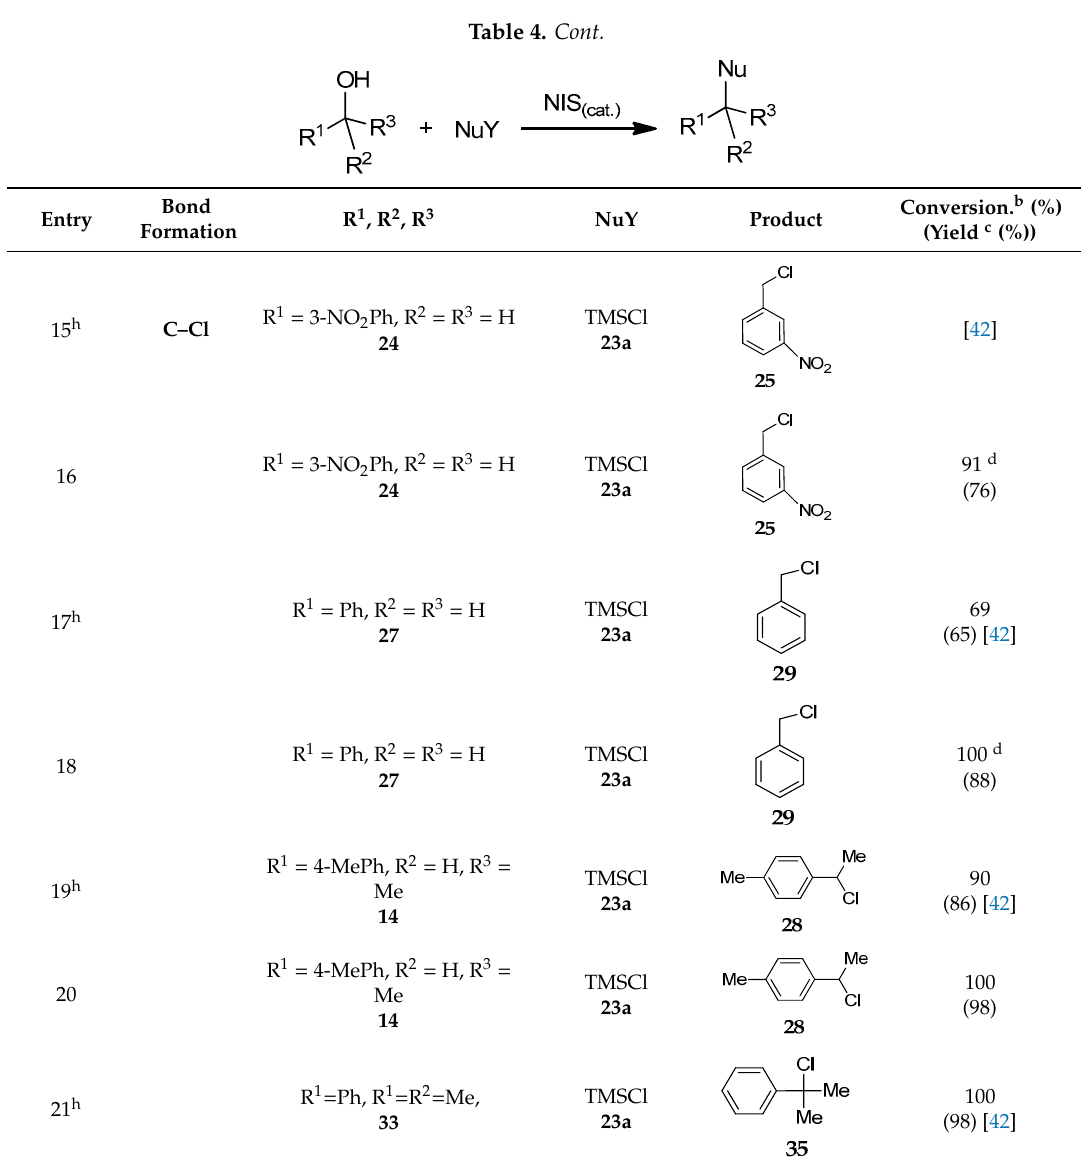
Table 4. Nucleophilic substitution of alcohols using NIS mediator Table 4. Cont.